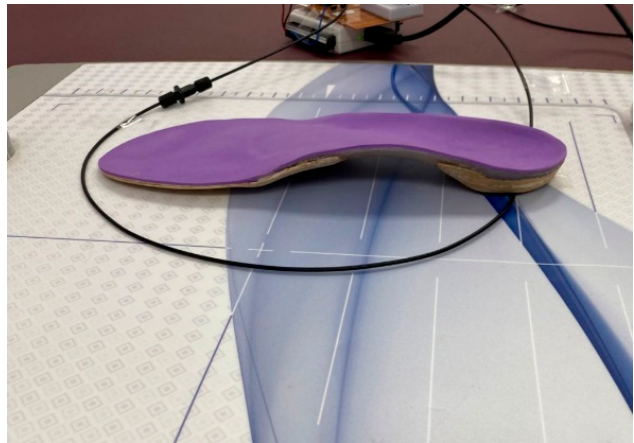
Figure 3. Configuration of optical sensor and insole on top of a commercial force platform.